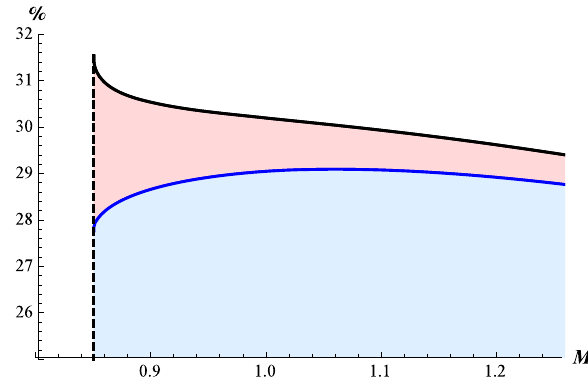
Fig. 6 The upper limit of the radiation under the collision in α = 1 / 16 √ and γ = 2. The total energy of the radiation is a black line , and the radiated energy from the mass of inside of the horizon is given as a blue line dilaton hair to the total mass of the initial black holes is larger when the mass is smaller, which can be seen from the solution of the black